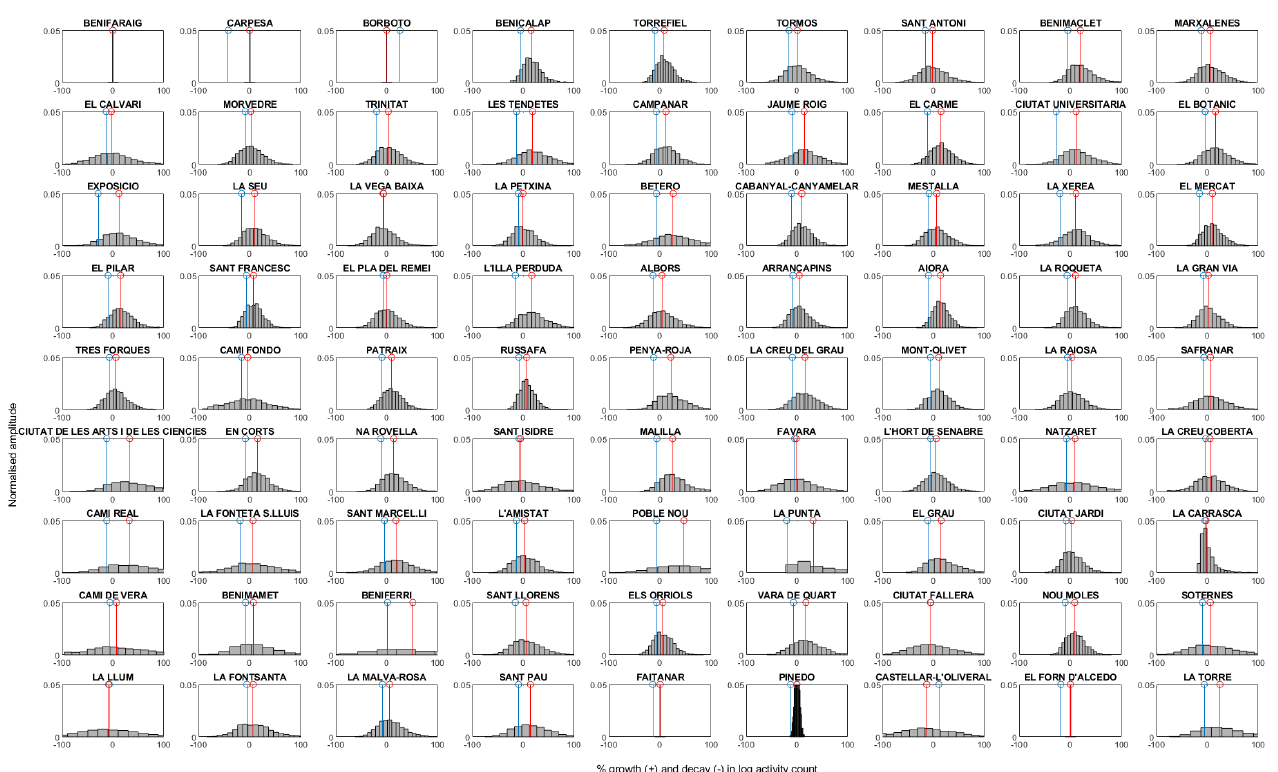
Figure 21. Normalised histograms of log counts in 2020 per province as obtained from MC simulations with true change (circle in blue) and sample median (circle in red). The closer the blue circle is to the red circle, the most accurate is the median